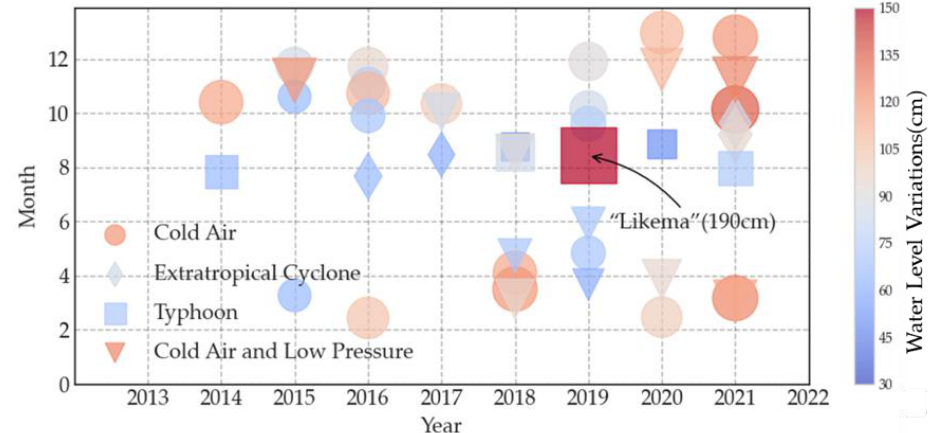
surges, particularly the one caused by the 2019 typhoon ‘ Likema ’ , which reached 190 cm and emerged as the largest surge since 2014.